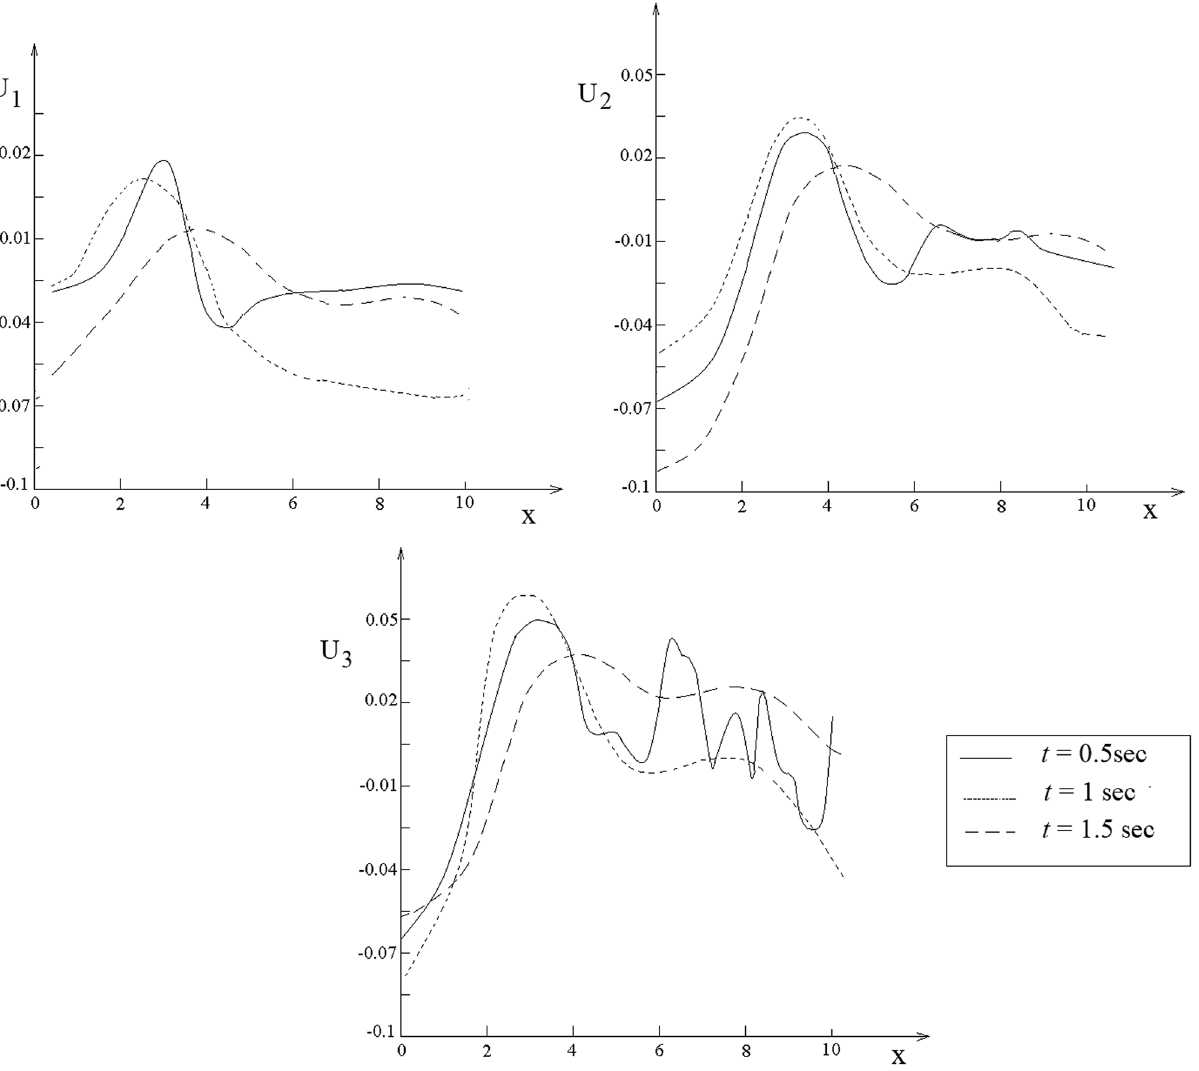
Figure 10. Plots of U 1 , U 2 and U 3 with respect to x